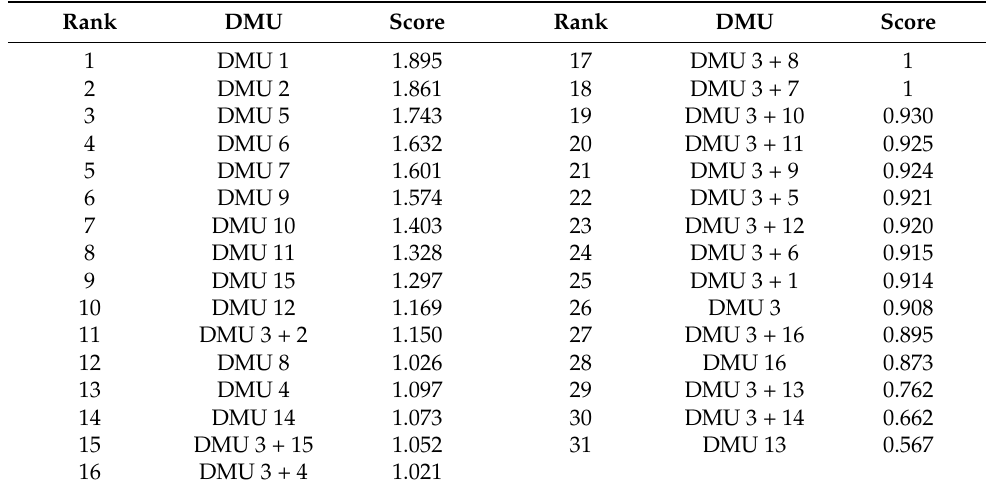
Table 11. Performance ranking of virtual DMUs after